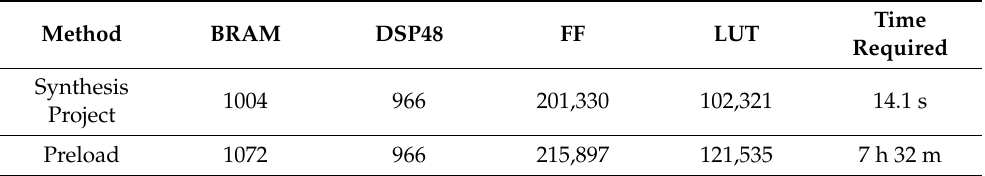
Table 4. Comparison of two methods of updating model weights.